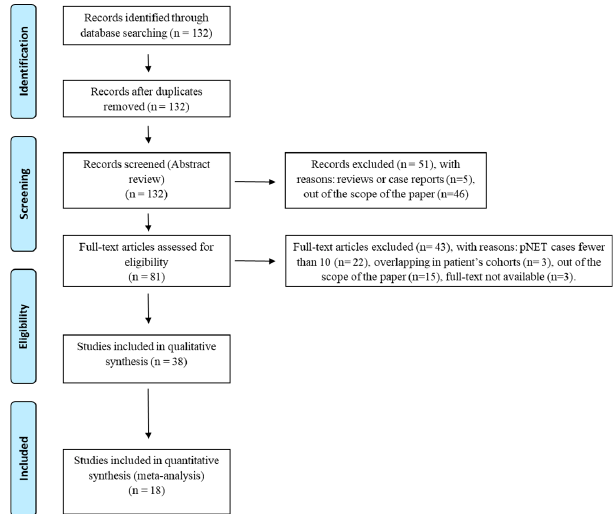
Figure 1. PRISMA flow-chart. Selection process of studies included in the qualitative and quantitative analysis according to the PRISMA flow diagram [13].